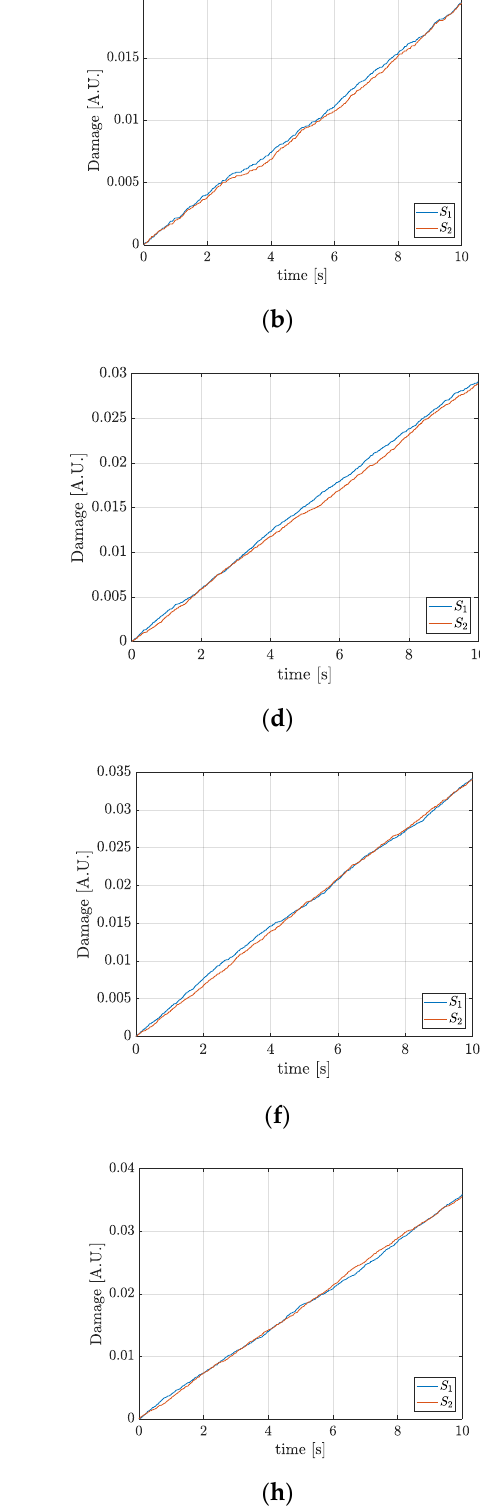
Figure 5. Typical simulation results of PRPD pattern and accumulated damage function for the four applied voltage magnitudes in the second case study: ( a ) and ( b ) 14 kV; ( c ) and ( d ) 16 kV; ( e ) and ( f ) 18 kV; ( g ) and ( h ) 20 kV.